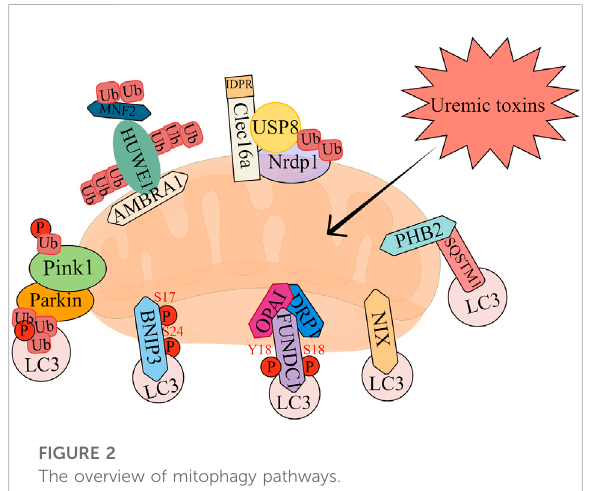
FIGURE 2 The overview of mitophagy